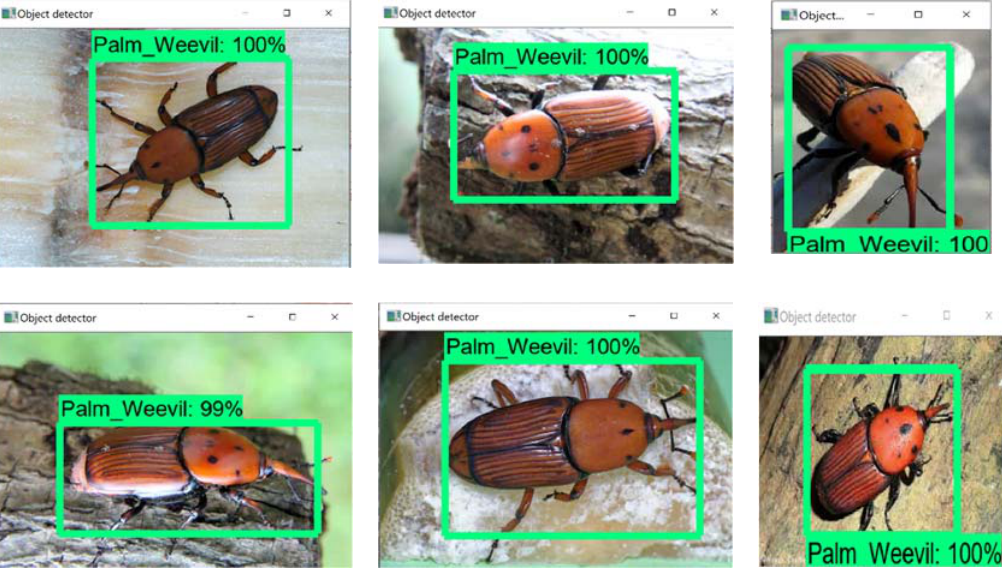
Figure 5. RPW results of the proposed model.